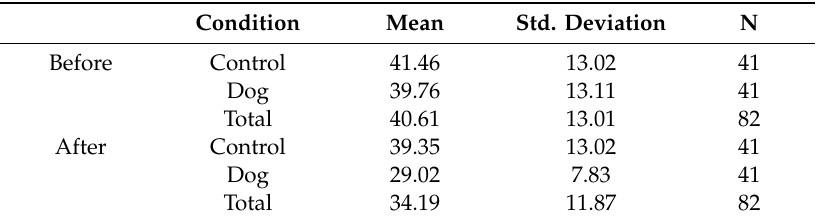
Table 1. Descriptive Statistics: